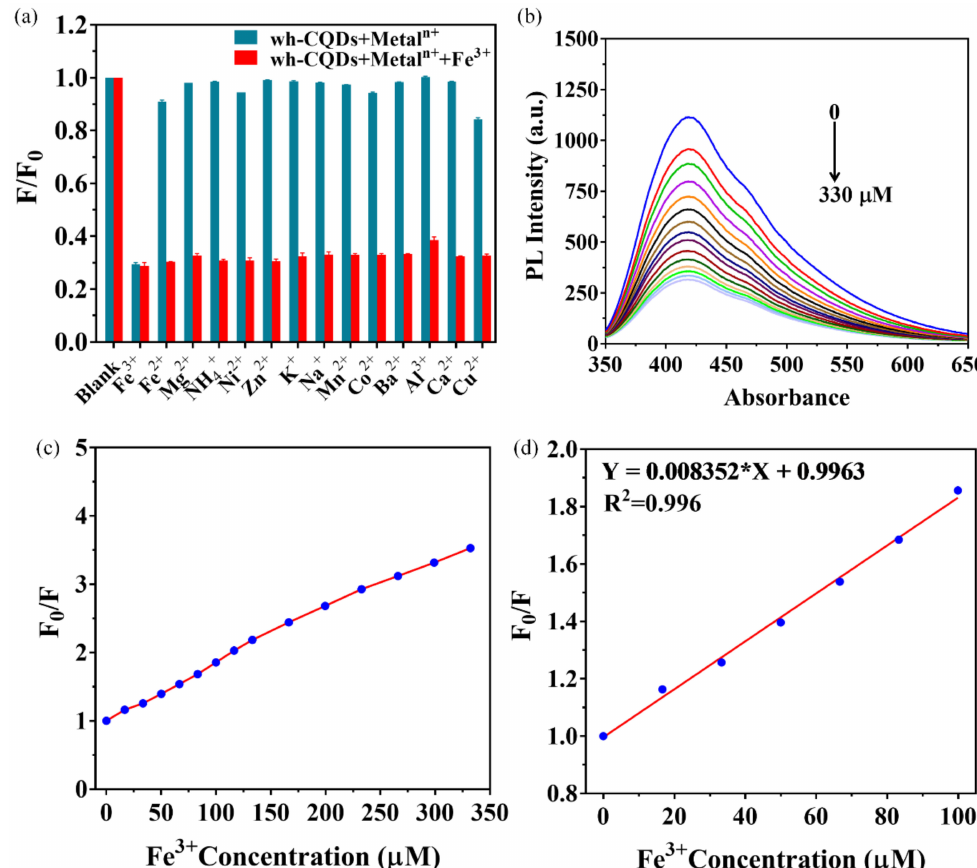
Figure 6. ( a ) The relative fluorescence intensities (F/F 0 ) of the wh-CQDs in the presence of individual metal ions (blue column) and co-presence of Fe 3+ ion with other metal ions (red column), ( b ) the fluorescent emission spectra of the wh-CQDs under various Fe 3+ ion concentrations (0–330 µ M), ( c ) the dependence of relative fluorescence (F/F 0 ) of the wh-CQDs on the concentration of Fe 3+ ions ranging from 0–330 µ M, ( d ) the Stern–Volmer plots for the concentration of Fe 3+ in the range of 0–100 µ